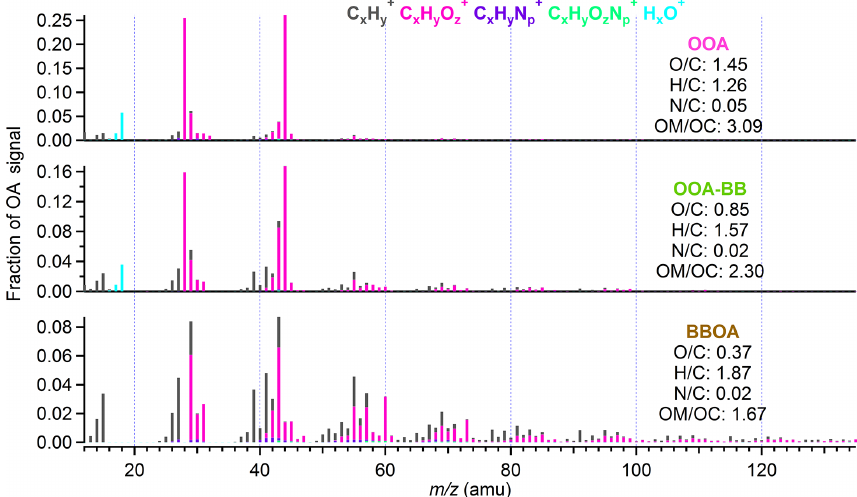
Figure 4. The mass spectra of each factor resolved by PMF, together with the atomic ratios of each